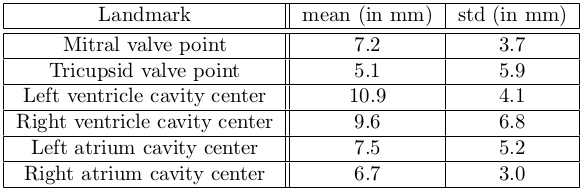
Table from the paper: Cardiac Motion Analysis by Temporal Flow Graphs
Table text:
Landmark
mean(inmm)
std(inmm)
Mitralvalvepoint
7.2
3.7
Tricupsidvalvepoint
5.1
5.9
Leftventriclecavitycenter
10.9
4.1
Rightventriclecavitycenter
9.6
6.8
Leftatriumcavitycenter
7.5
5.2
Rightatriumcavitycenter
6.7
3.0